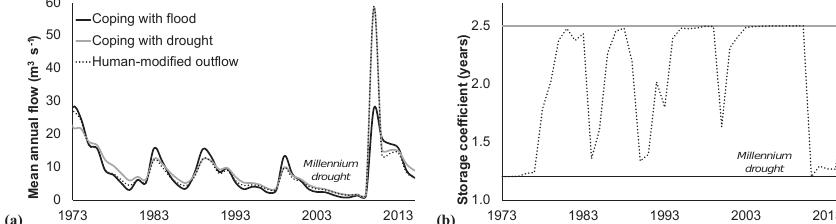
Figure 5. Example of flood after drought. (a) Human-modified outflows (dotted line) that result from changing storage coefficient (b) be- tween the values aiming to cope with flood (black continuous line) and aiming to cope with drought (grey line).